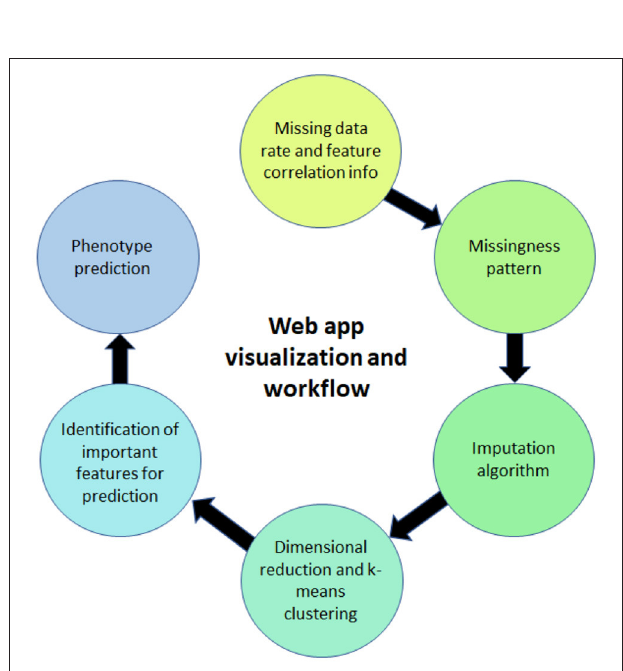
FIGURE 4 | Illustration of the web app for